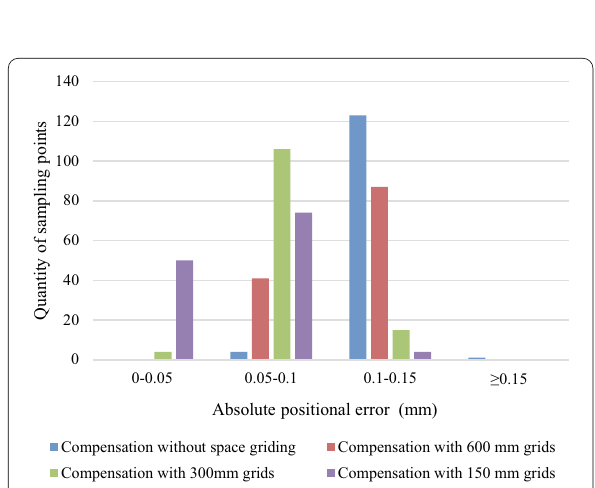
Figure 16 Compensation results of different size grids